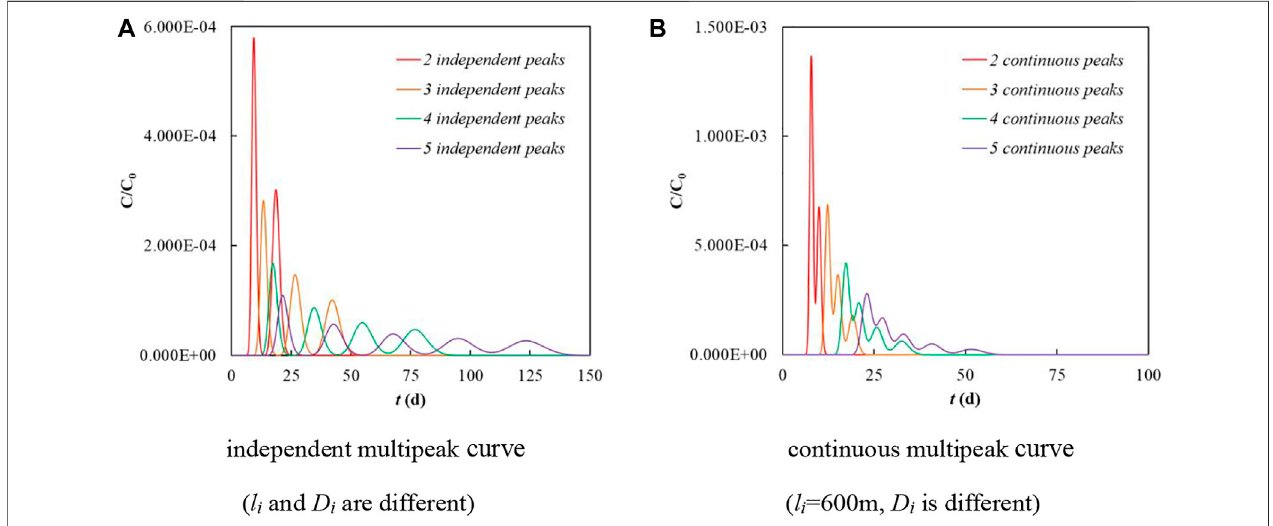
FIGURE 14 | Tracer output curve of interwell multifracture in parallel under different parameters. (A) independent multipeak curve ( l i and D i are different) (B) continuous multipeak curve ( l i =600 m, D i is different).